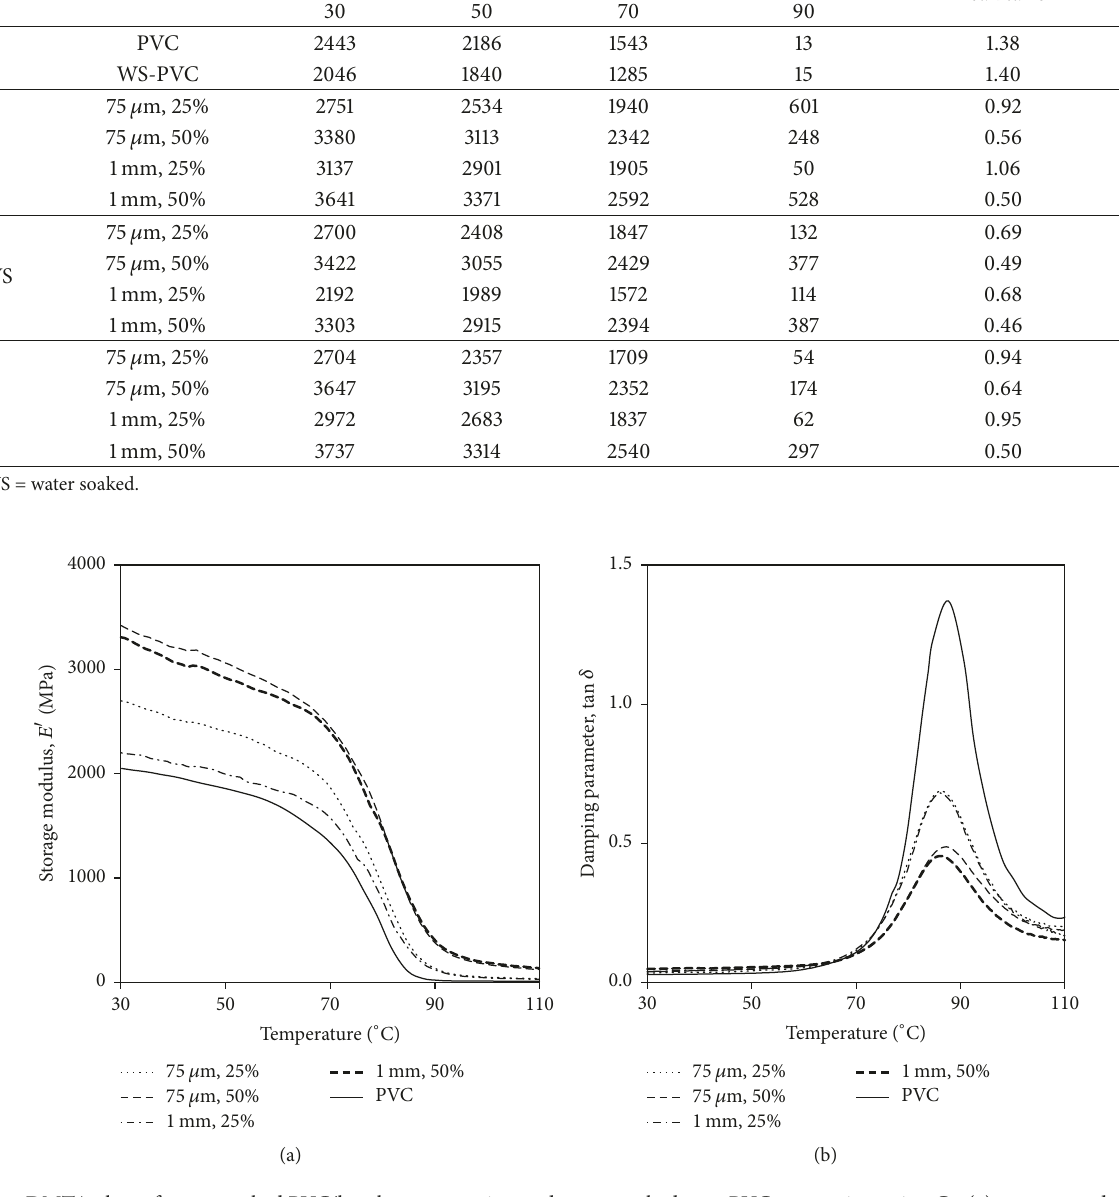
Figure 5: DMTA plots of water-soaked PVC/bamboo composites and water-soaked pure PVC composites using C 1 : (a) storage modulus, 𝐸 󸀠 , and (b) tan 𝛿